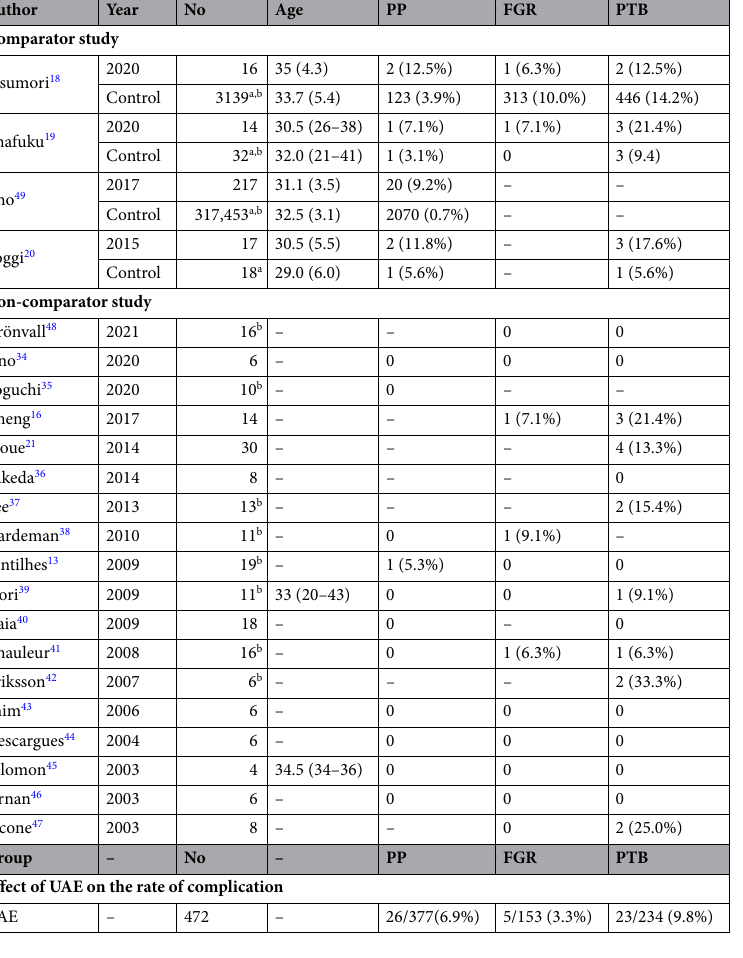
Table 3. Summary of the rate of PP, FGR and PTB in subsequent pregnancies after UAE. Median (range) or mean (standard deviation) or number (percentage per column) are shown. a Women without prior UAE. b Some patients had multiple deliveries. Some values listed above might be slightly different from the original ones due to the estimation procedure used by the authors. – not applicable, PP placenta previa, FGR fetal growth restriction, PTB preterm birth, UAE uterine artery embolization, No . number of prior uterine embolization